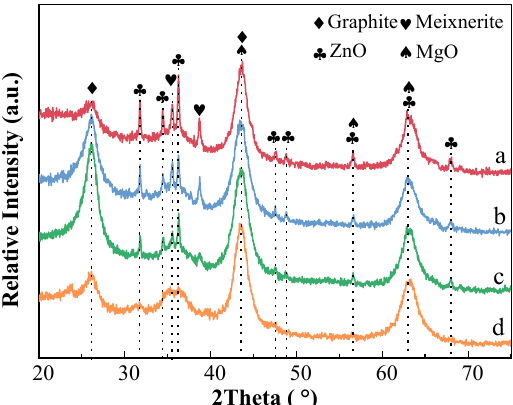
Figure 5. XRD patterns of the used PtIn/MAZ catalytic system reduced with different atmospheres: (a) H 2 /N 2 ; (b) C 3 H 8 /H 2 /N 2 ; (c) C 3 H 8 ; (d) CO (reduction conditions: T = 600 °C, t = 2.5 h; reaction conditions: T = 600 °C, WSHV = 3 h − 1 , atmospheric pressure in the gas mixture of C 3 H 8 :H 2 :N 2 molar ratio = 8:7:35 for 17 h).